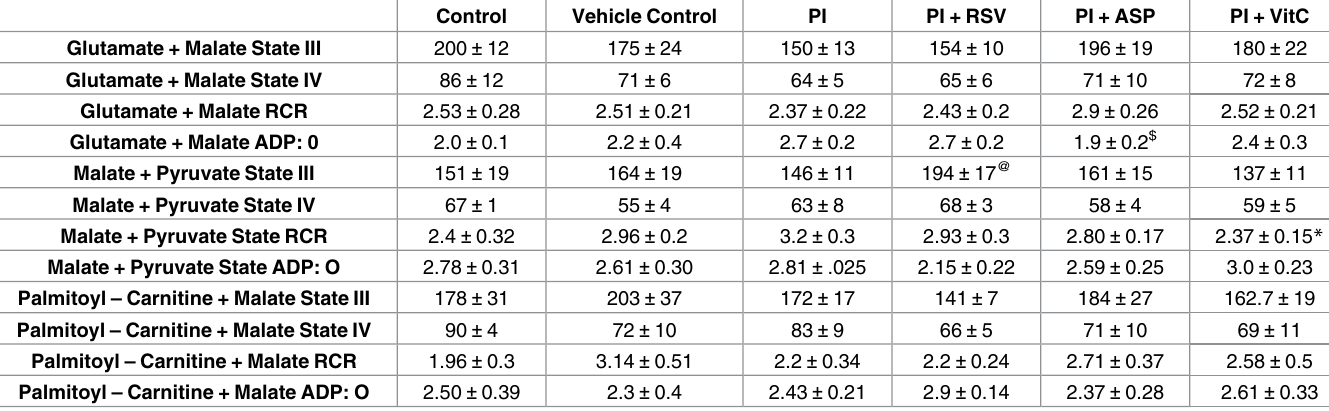
Table 4. Function of Isolated Left Ventricular Mitochondria after 4 Months of PI Treatment. Control Vehicle